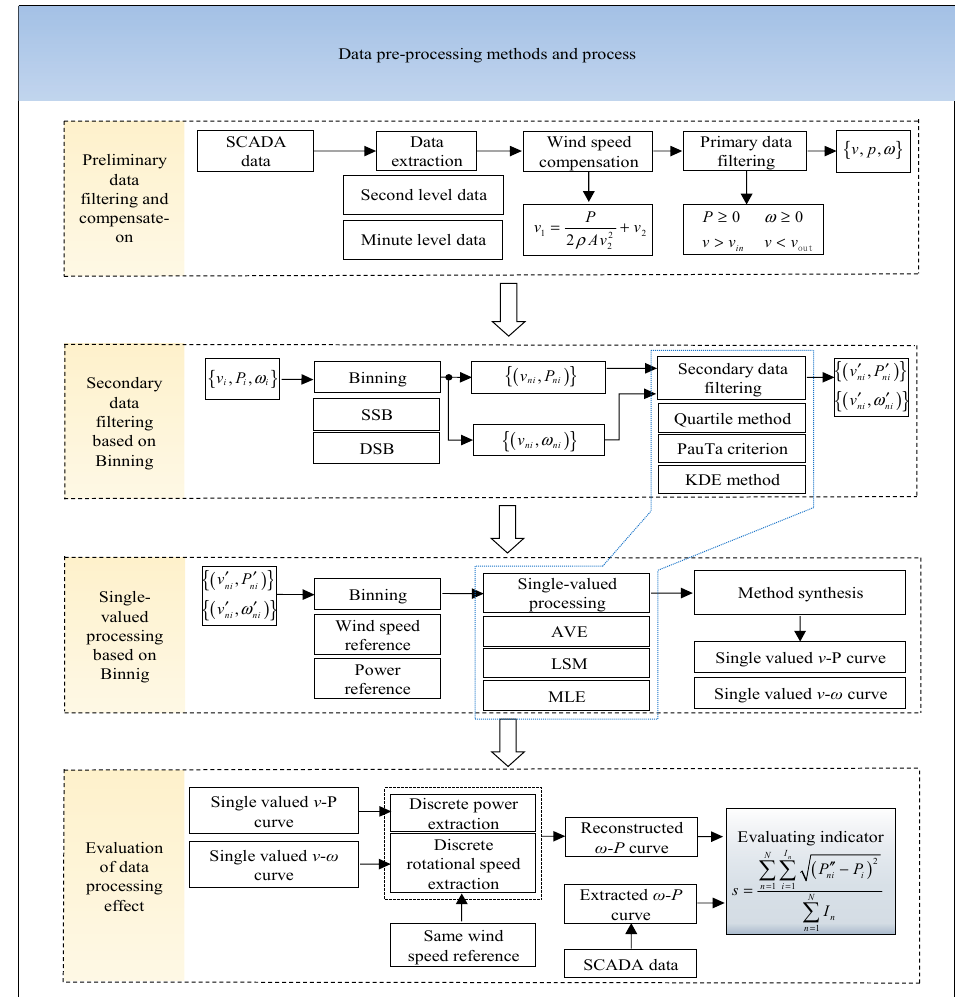
Figure 7. Data pre-processing methods and process.